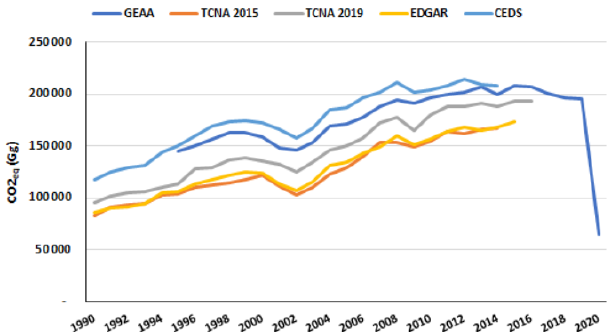
Figure A7. Comparison of annual GHG emissions for the energy sector between the different inventories considered in this work (see Table